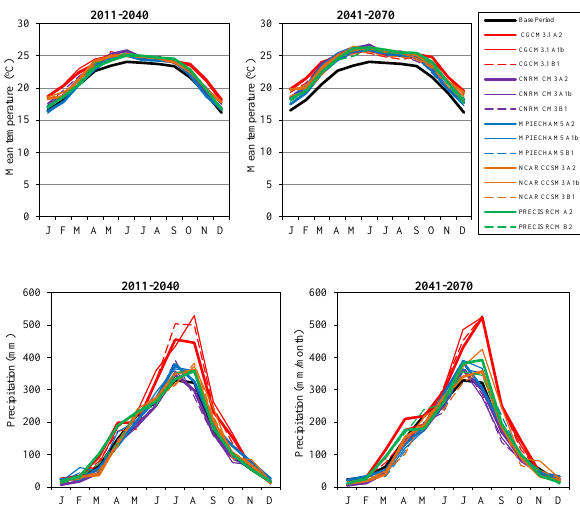
Fig. 6. Probability density functions of annual mean temperature and annual precipitation data for all climate projections, and for the 1971–2000 as base period. PDFs are presented for the 2011–2040 and 2041–2070 time